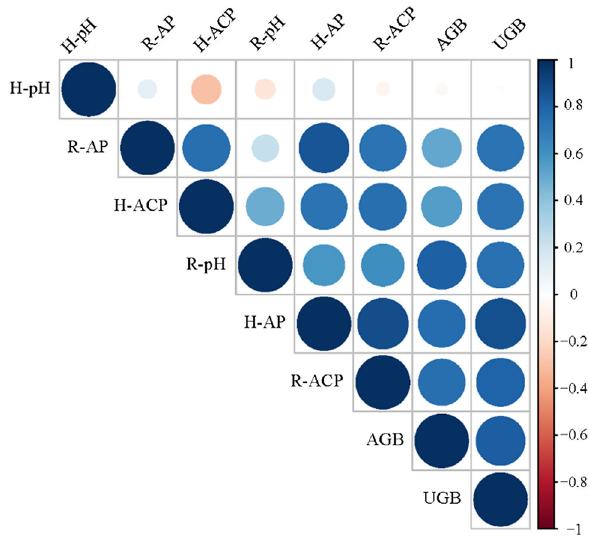
Fig. 4 The spearman correlation analysis between